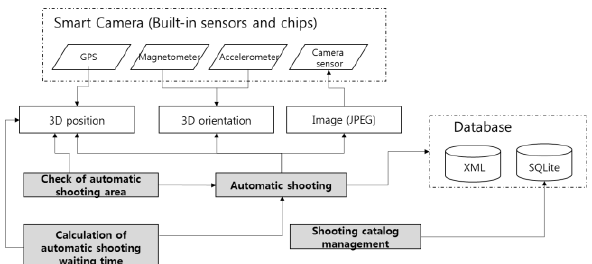
Figure 2. Diagram of the automatic shooting module